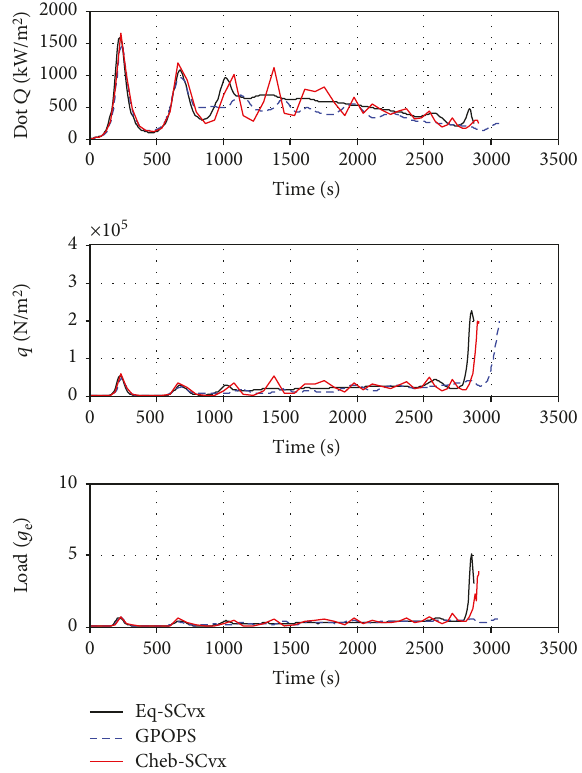
Figure 6: Heat fl ux, dynamic pressure, and normal load